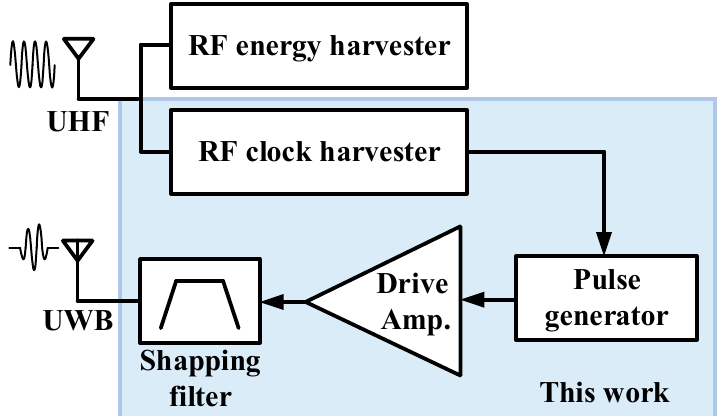
Figure 1. Block diagram of the proposed ultrawideband (UWB) transmitter with the injection-locked radio frequency (RF) clock harvester.